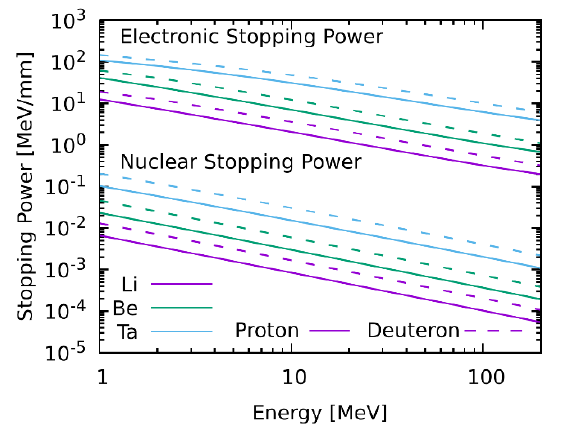
Figure 2: Stopping power, i.e. energy loss per path length traveled for protons and deuterons in Li, Be and Ta. The stopping power was calculated using SRIM 2013 [14].